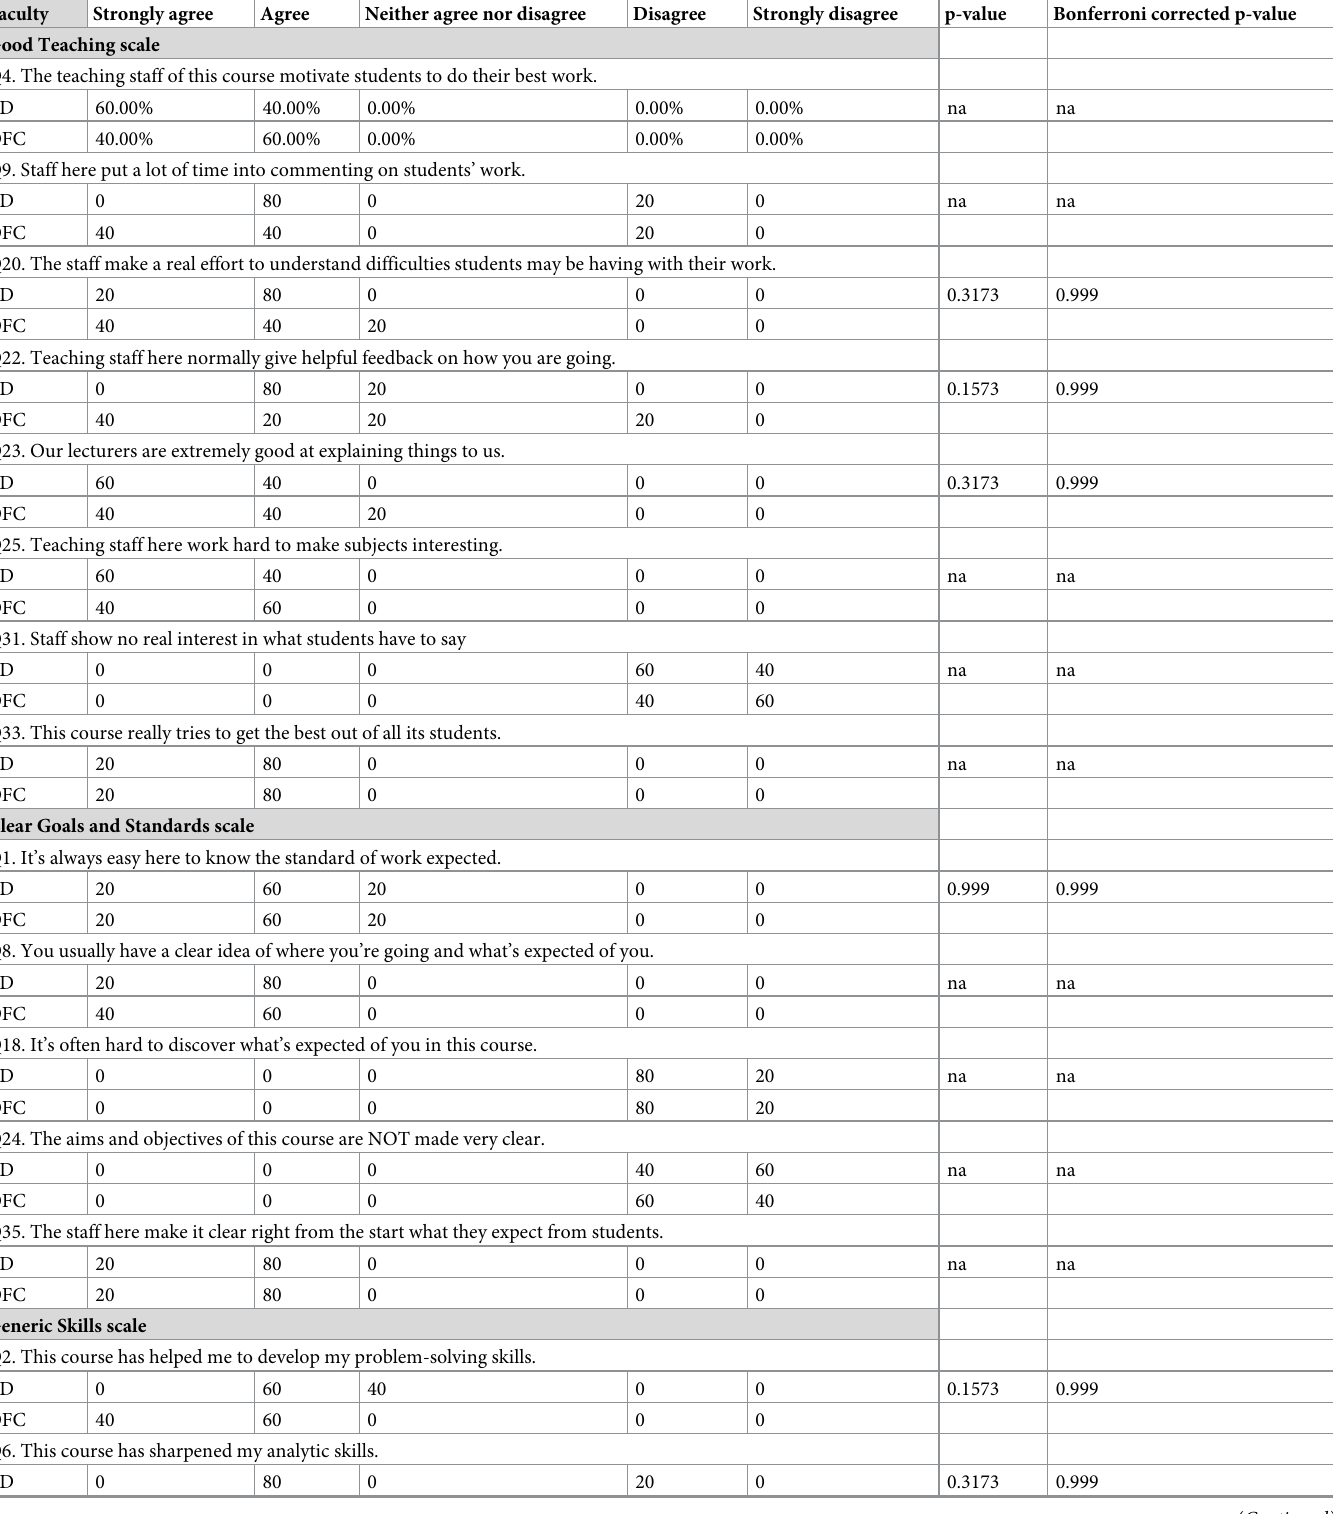
Table 4. Comparison of faculty perspectives between traditional classroom and online flipped classroom